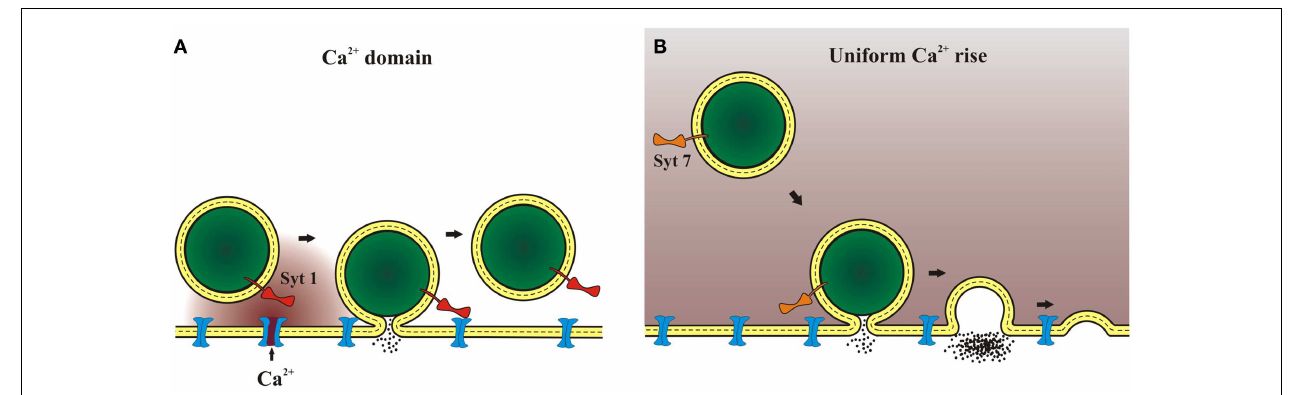
bulk Ca 2 + . Bulk Ca 2 + can also rise as a result of Ca 2 + release from internal stores. After the stimulus ends the Ca 2 + gradients around individual vesicles will collapse as Ca 2 + diffuses through the cytoplasm away from the membrane.This will lead to a more uniform, moderate concentration that can persist for seconds. A Ca 2 + sensor such as syt 7, with its slow kinetics and high affinity, can be activated by a Ca 2 + signal of this